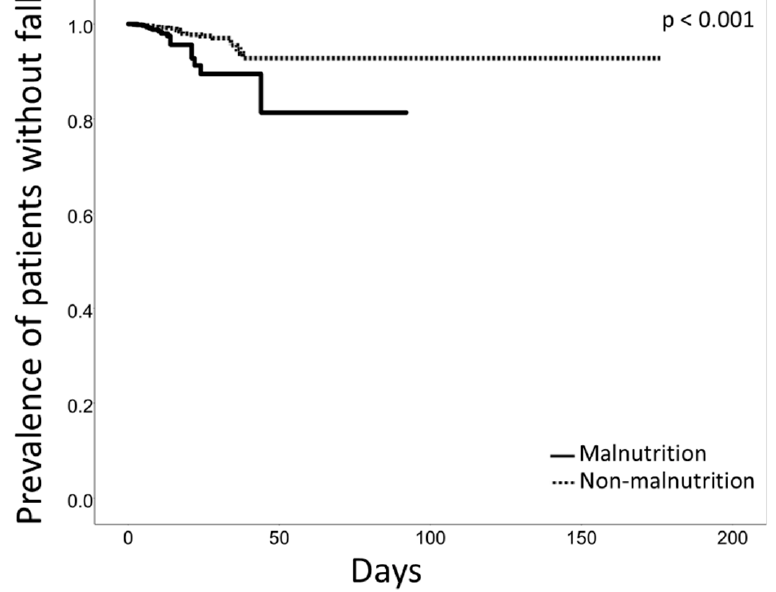
Figure 2. Kaplan–Meier curve analysis for the first fall and the length of the hospital stay. Malnourished patients (solid line) had a higher fall rate than patients without malnutrition (dotted line, log-rank test p < 0.001). The number of patients remaining at days 5, 10, 15, 20, 30, and 50 were 449, 263, 138, 77, 26, and 5, respectively, in the malnutrition group; and 2991, 1655, 865, 494, 195, and 46, respectively, in the non-malnutrition group.